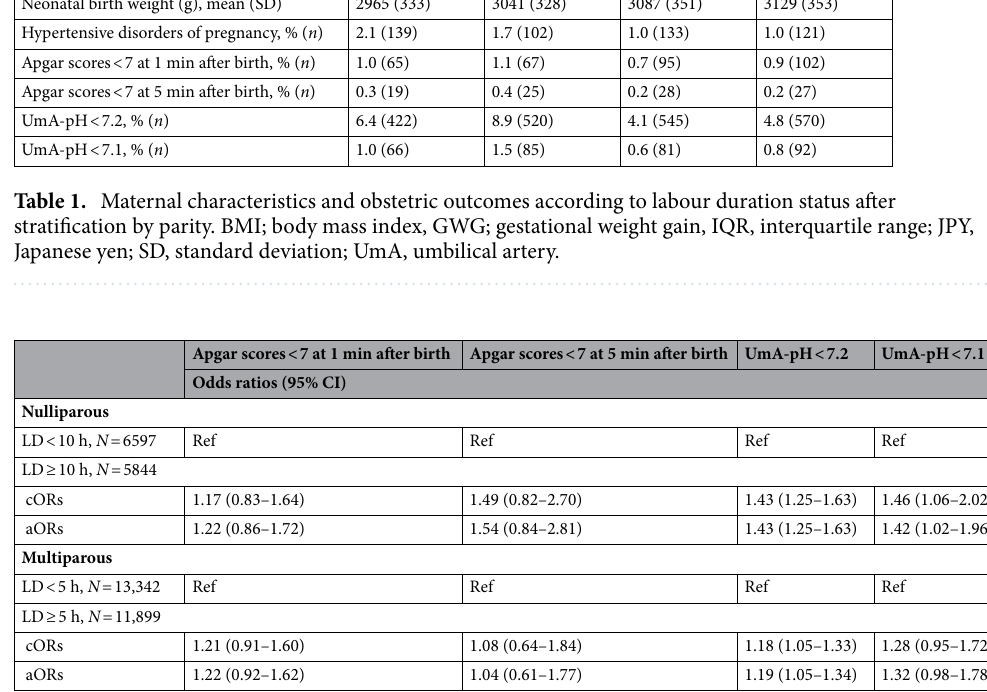
Table 2. Odds ratios for low neonatal Apgar scores and foetal acidosis in nulliparous and multiparous participants with over-median labour duration. Maternal age, pre-pregnancy body mass index, gestational weight gain, maternal smoking status, maternal alcohol consumption status, maternal educational status, annual household income, neonatal birth weight, and presence of hypertensive disorders of pregnancy were used as confounding factors. aORs, adjusted odds ratios; CI, confidence interval; cORs, crude odds ratios; LD, labour duration; Ref, reference; UmA, umbilical artery.